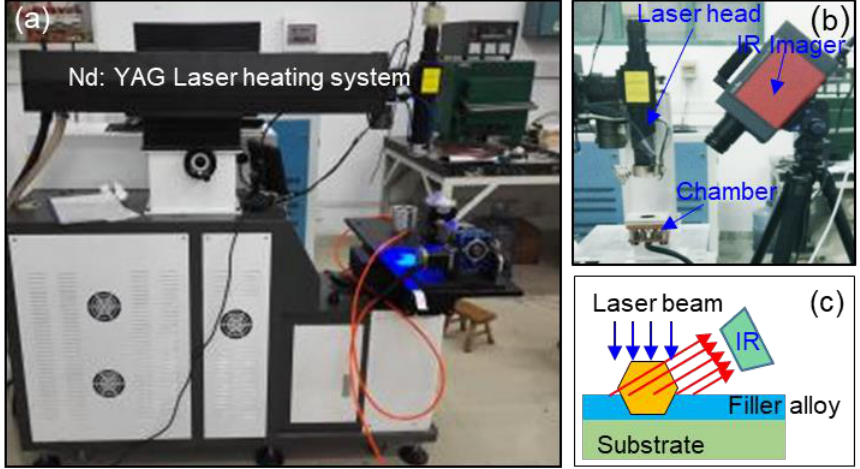
Figure 1. Experimental setup: ( a ) laser heating device, ( b ) temperature monitor, and ( c ) laser heating zone in the chamber.